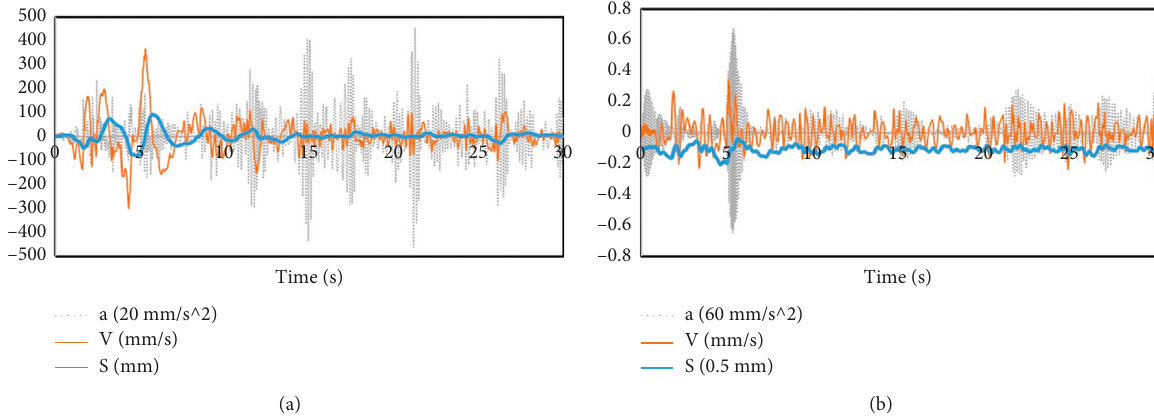
Figure 49: Time course curves of bearing deformation displacement, velocity and acceleration when ELC is input from X direction. (a) Horizontal deformation. (b) Vertical deformation.